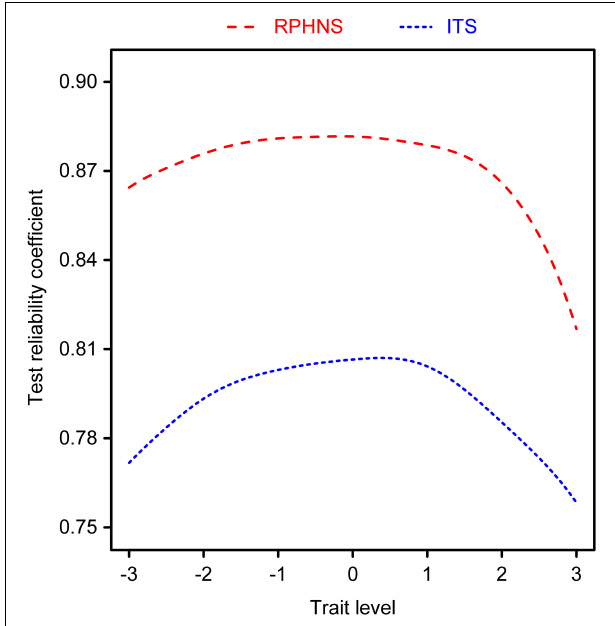
FIGURE 1 | Reliability chart of scales by different trust properties.